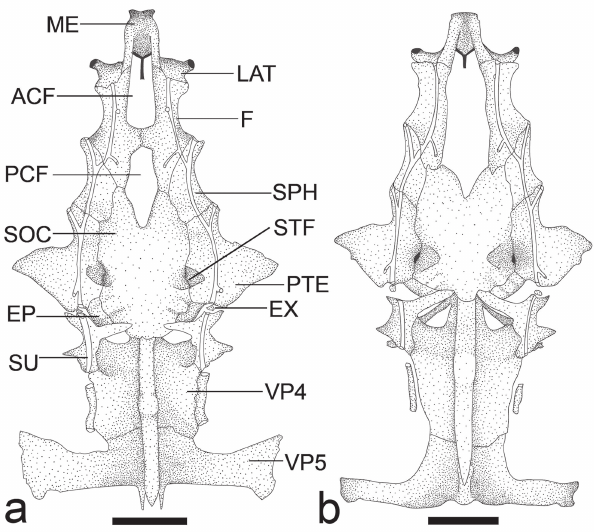
Fig. 3. Dorsal view of neurocranium and Weberian